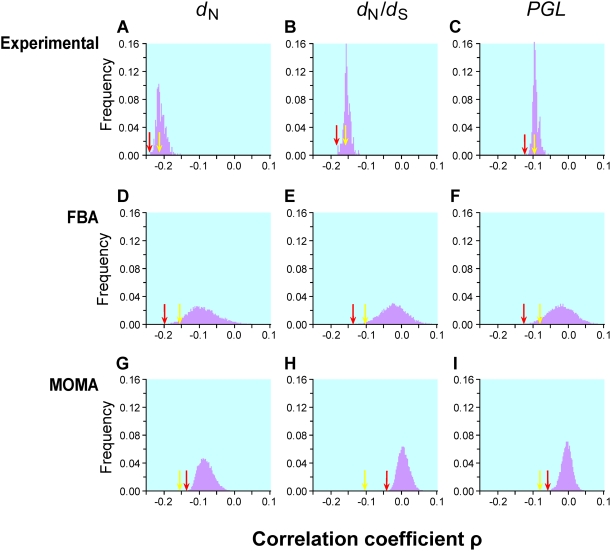
Frequency distributions of Spearman's rank correlation coefficient ρ between gene importance (i.e., fitness reduction upon gene deletion) and evolutionary rate across many conditions.Gene importance is measured by experiments in 418 lab conditions (panels A–C), predicted by FBA for enzyme genes in 104 simulated nutritional conditions (D–F), or predicted by MOMA for enzyme genes in the same 104 conditions (G–I). Gene evolutionary rate is measured by nonsynonymous substitution rate d
N (A, D, G), nonsynonymous/synonymous rate ratio d
N/d
S (B, E, H), or propensity for gene loss PGL (C, F, I). The yellow arrow in each panel indicates the observed correlation using gene importance values experimentally determined in the YPD medium and the red arrow indicates the strongest correlation across the conditions examined. The numbers of genes used are 3999 for panels A–C, 478 for panels D, E, G, and H, and 546 for panels F and I. The gene number is lower than 546 for panels D, E, G, and H, because some S. cerevisiae genes do not have orthologs in S. bayanus. The yellow arrow is on the left-hand side of the red arrow in panels G, H, and I, because, under all simulated conditions, MOMA-predicted fitness values have weaker correlations with the evolutionary rates than that observed under YPD.